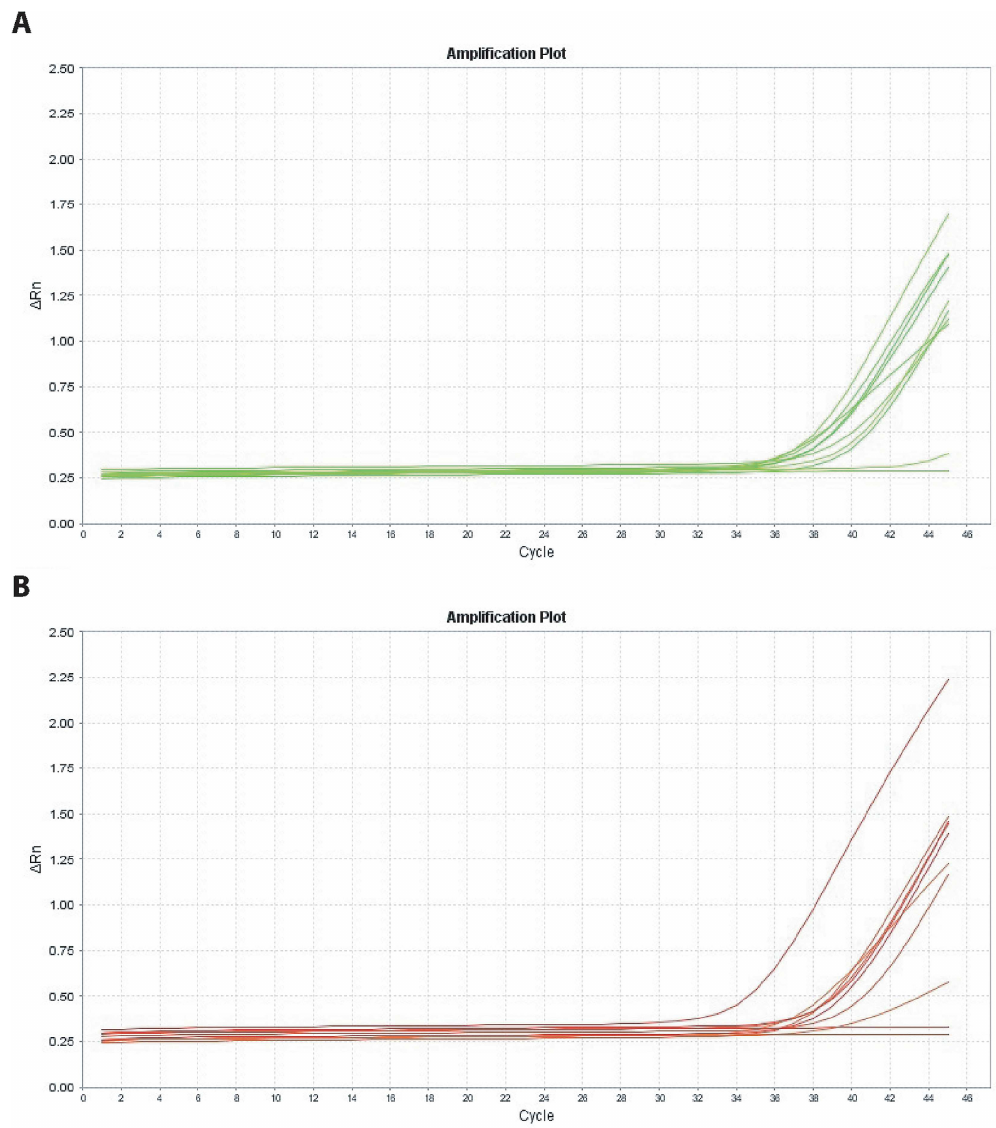
subtracting the baseline( Δ Rn =